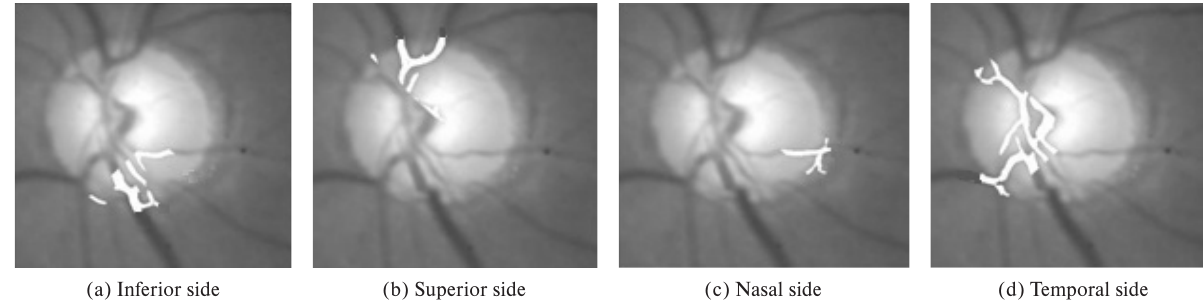
Fig. 3. Segmented blood vessels for ab normal fundus images.